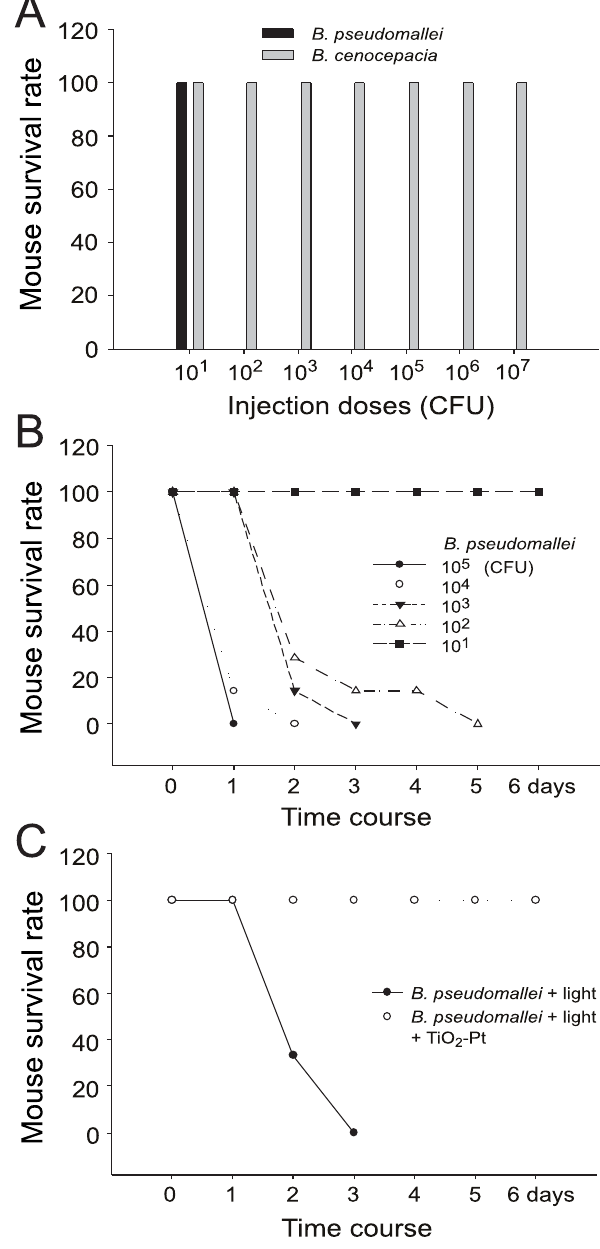
Figure 2. Mortality of mice receiving inoculations of B. pseudomallei with or without photocatalysis. The survival rate of mice receiving inoculations of various doses (10 1 –10 6 ) of B. pseudo- mallei vgh07 and B. cenocepacia P2 cells is shown. n=7, three experiments with 2 or 3 replicates (A). The survival rate and time course of mice treated with 10 1 –10 6 CFU of B. pseudomallei vgh07. n=7, three experiments with 2 or 3 replicates (B). The survival rate and time course of mice treated with 10 3 CFU of B. pseudomallei vgh07 with or without TiO 2 -Pt -mediated photocatalysis. n=6, three experiments with 2 replicates